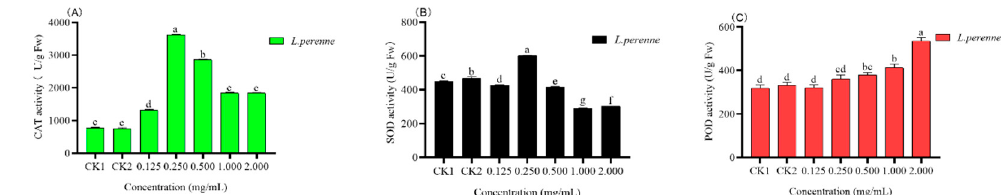
Figure 6. Effect of different concentration of L. pungens essential oil on malondialdehyde concentra- tion and electrolyte leakage (CK1, blank control; CK2, negative control; ( A ), Malondialdehyde; ( B ), Electrolyte leakage). Note: different lowercase letters (a–g) represent statistical differences (Tukey’s test p <